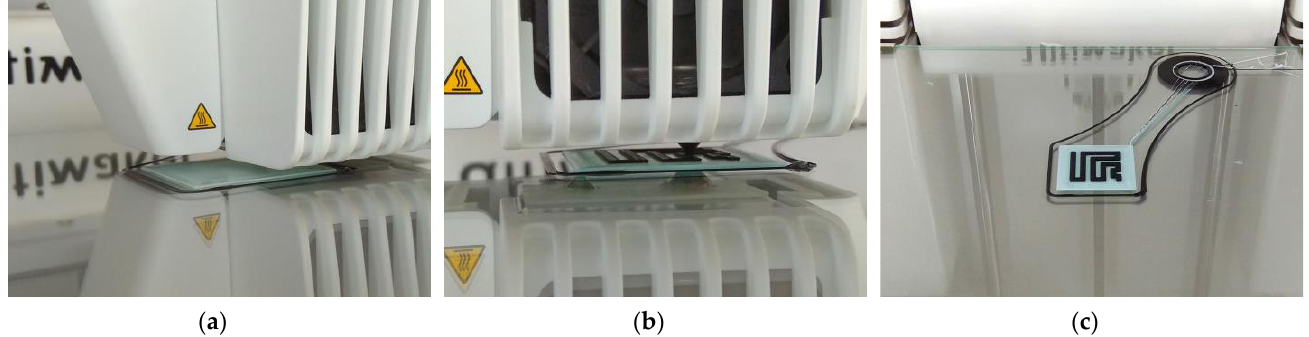
Figure 5. The main steps of printing procedure: ( a ) forming a flexible base, ( b ) adding the conductive paths and ( c ) finalizing the print (a raft in upper right corner was used for cleaning the print heads during the operation).